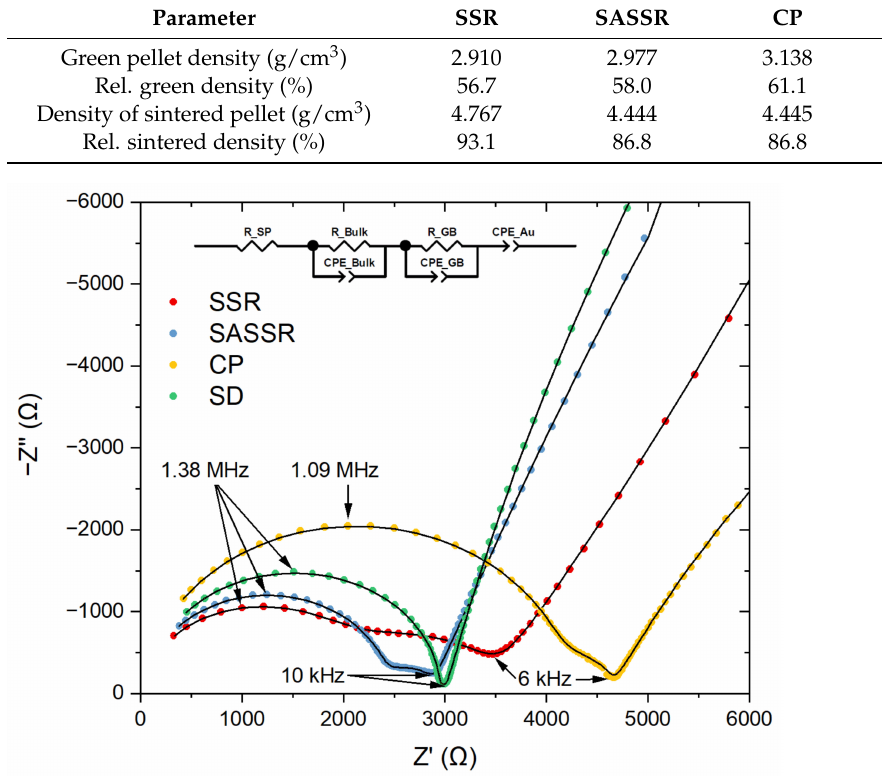
Figure 8. Nyquist plots and equivalent circuit fits of the impedance spectra for the samples of all four different synthesis routes (red—SSR; blue—SASSR; yellow—SD;